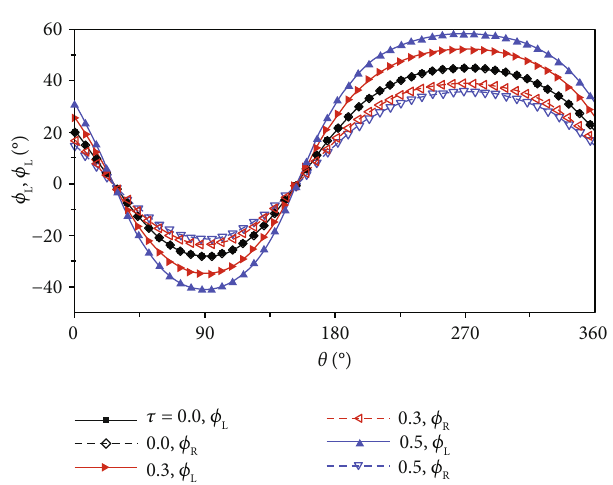
ϕ τ L and R at various